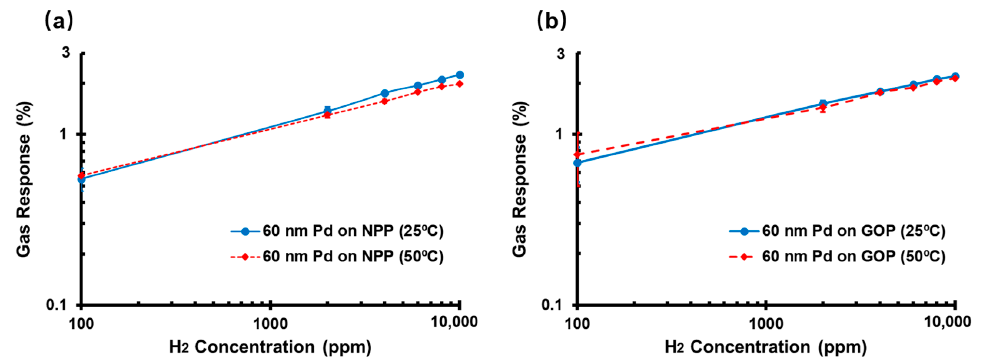
Figure 8. Effect of temperature on gas response for 60 nm Pd on ( a ) NPP (Reprinted with permission from Ref. [15]. 2022, Springer Nature) and ( b ) GOP substrates.